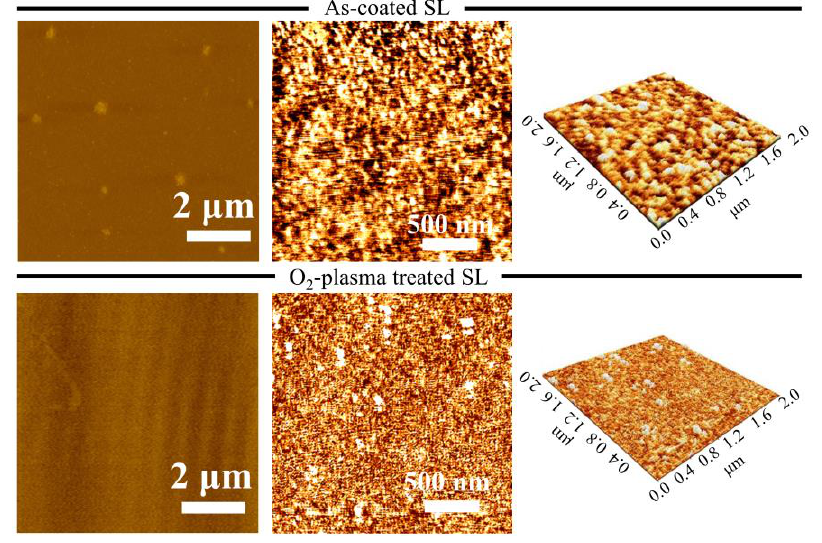
Figure 5. AFM images of as-coated ( top ) row and O 2 -plasma treated SL ( bottom ) row.